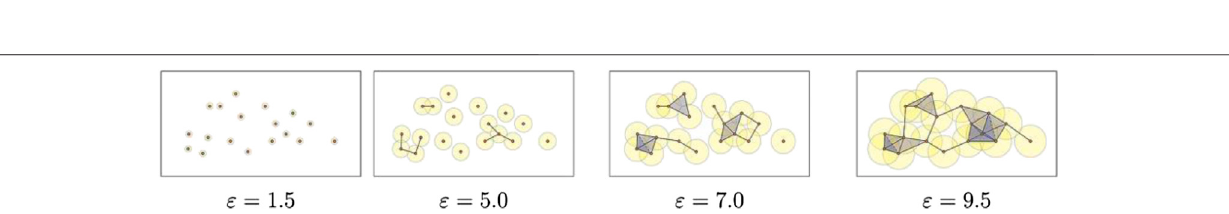
FIGURE2| Flowchartoftheprocedureimplemented.Therearetwoparts;the fi rstpartinvolvesdatacollectionandpre-processing.ThesecondpartregardsTDA- related computations.